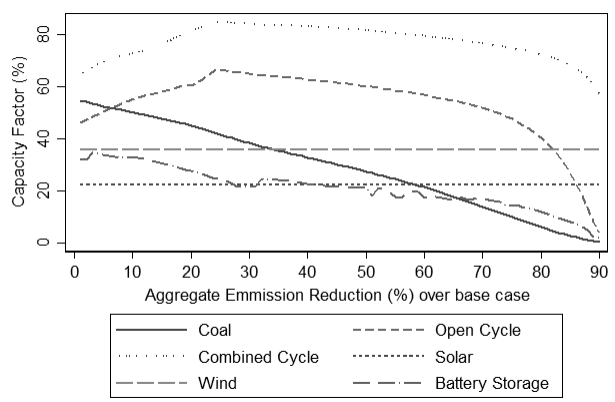
Figure 11. Generation shares with increasing carbon emission reduction target.